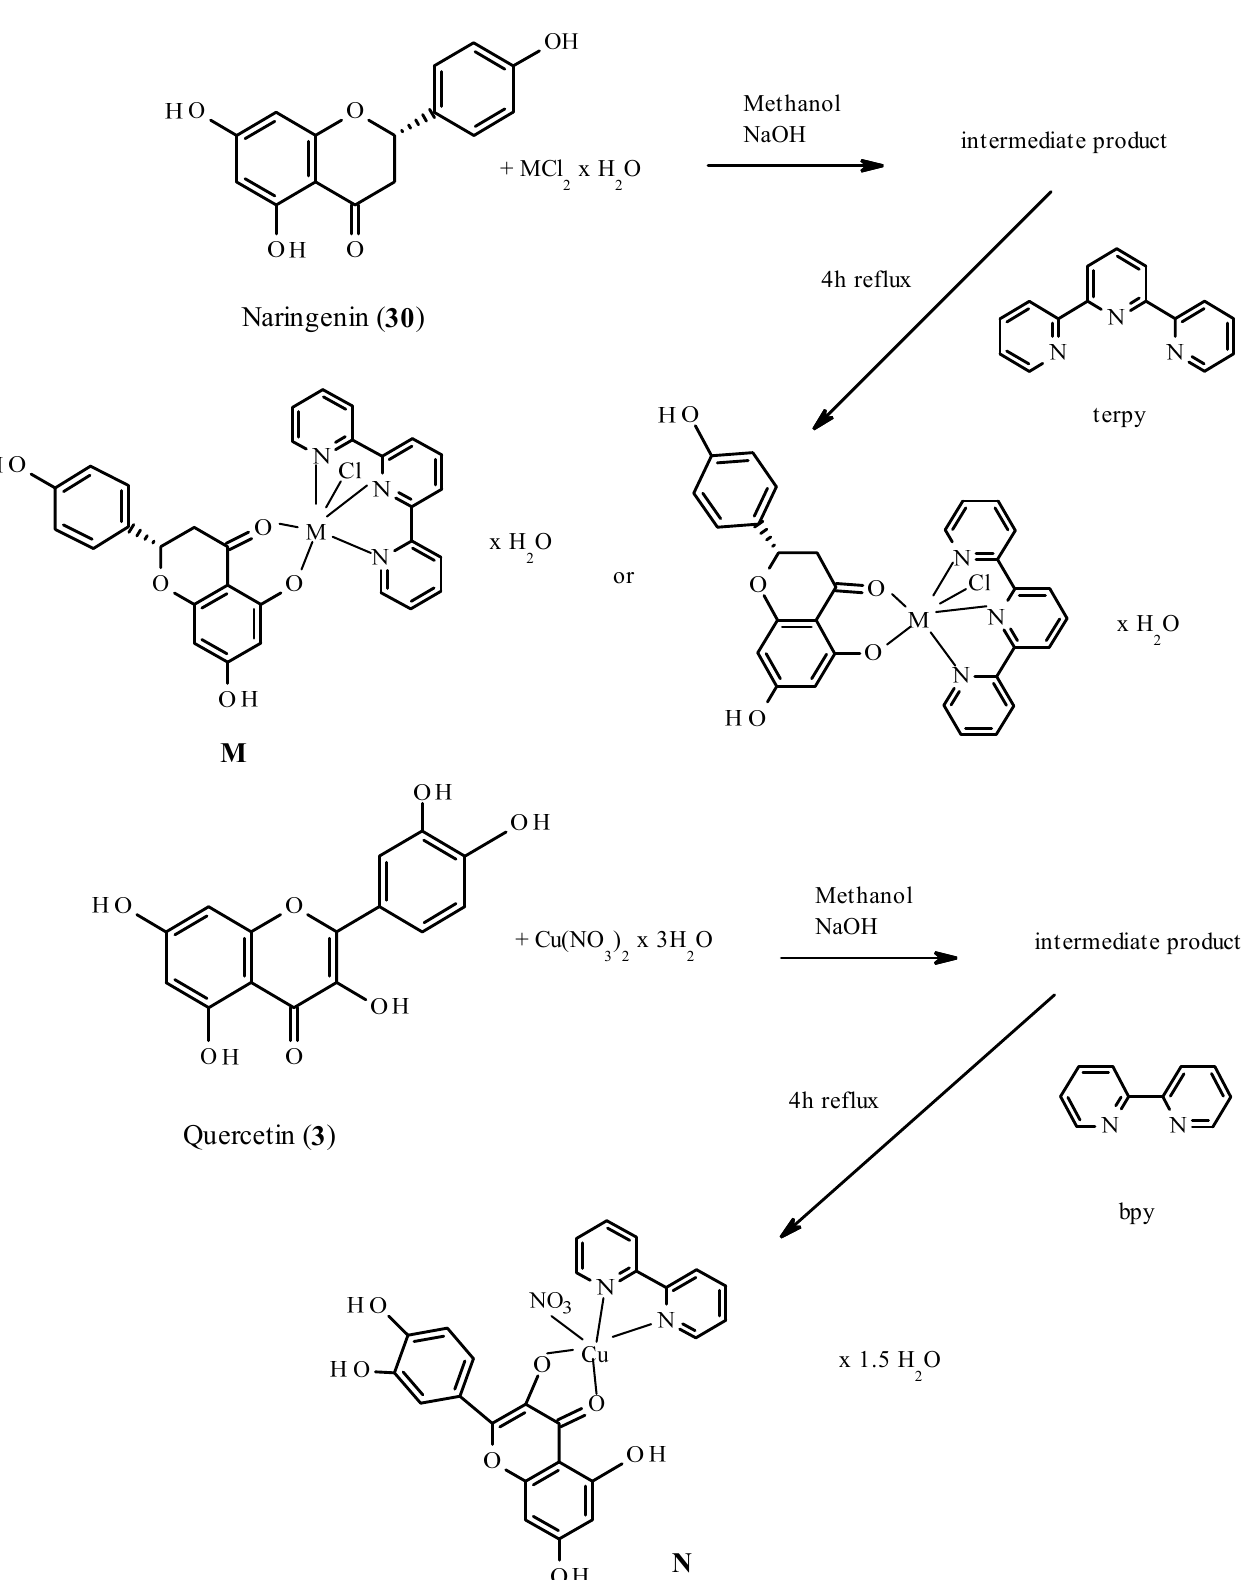
Scheme 2. Synthesis and possible structures of Ni(II) and Cu(II) complexes with quercetin ( 3 ) and naringenin ( 30 ).